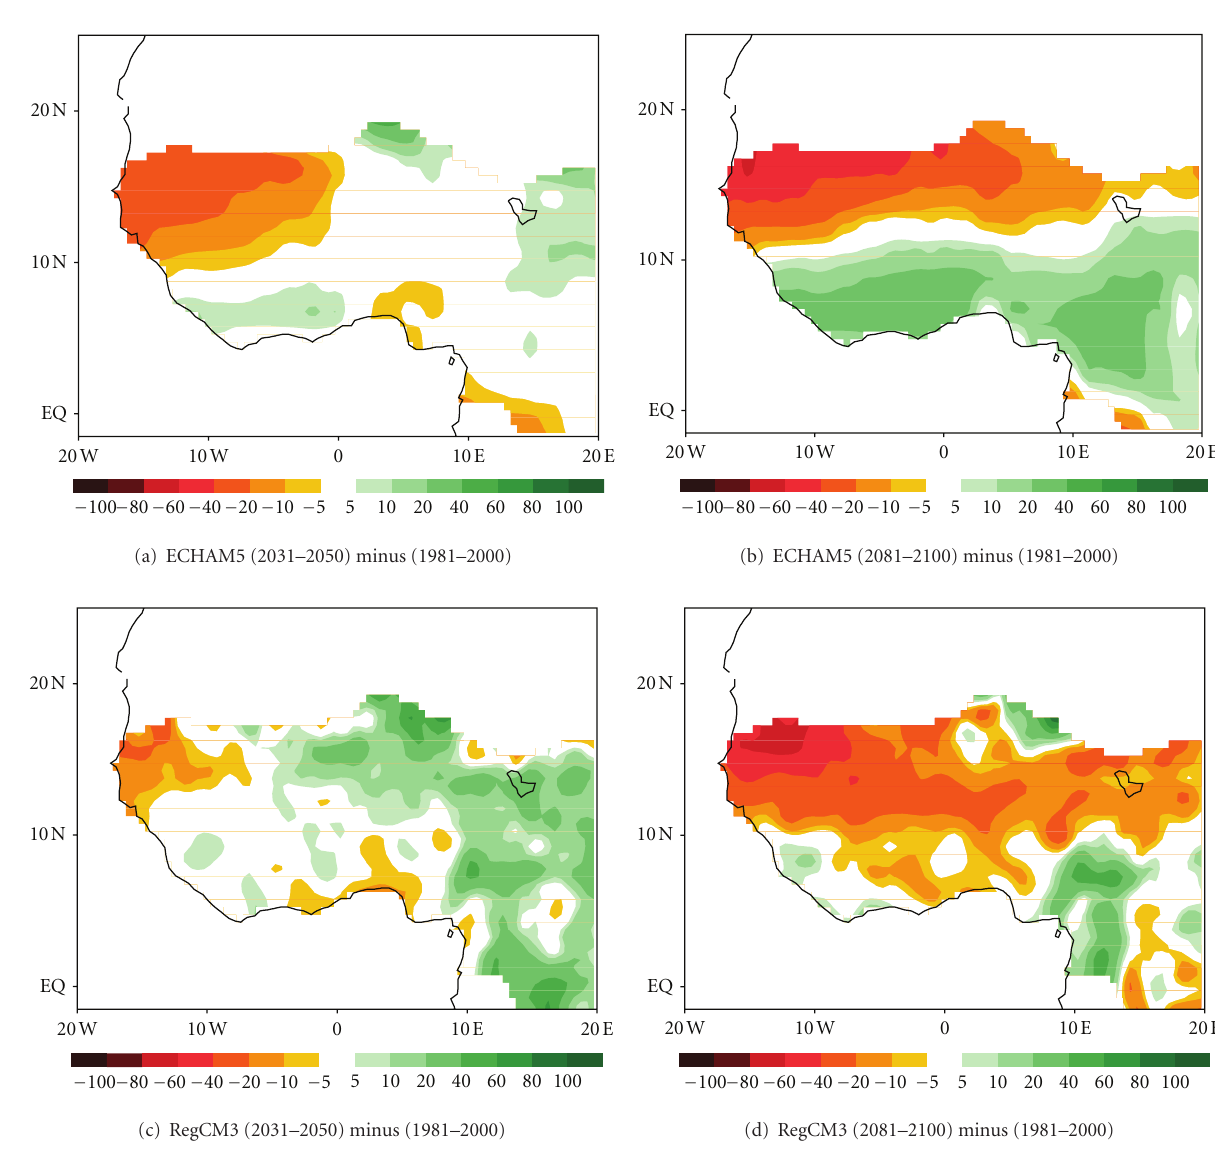
Figure 2: Summer (June–August) di ff erence (A1B minus reference) in mean precipitation from ECHAM5 (upper) and RegCM3 (lower) during the early (left) and the late (right) 21st century. Units are expressed as the percentage of present-day value, and only areas where changes are statistically significant at the 90% level are